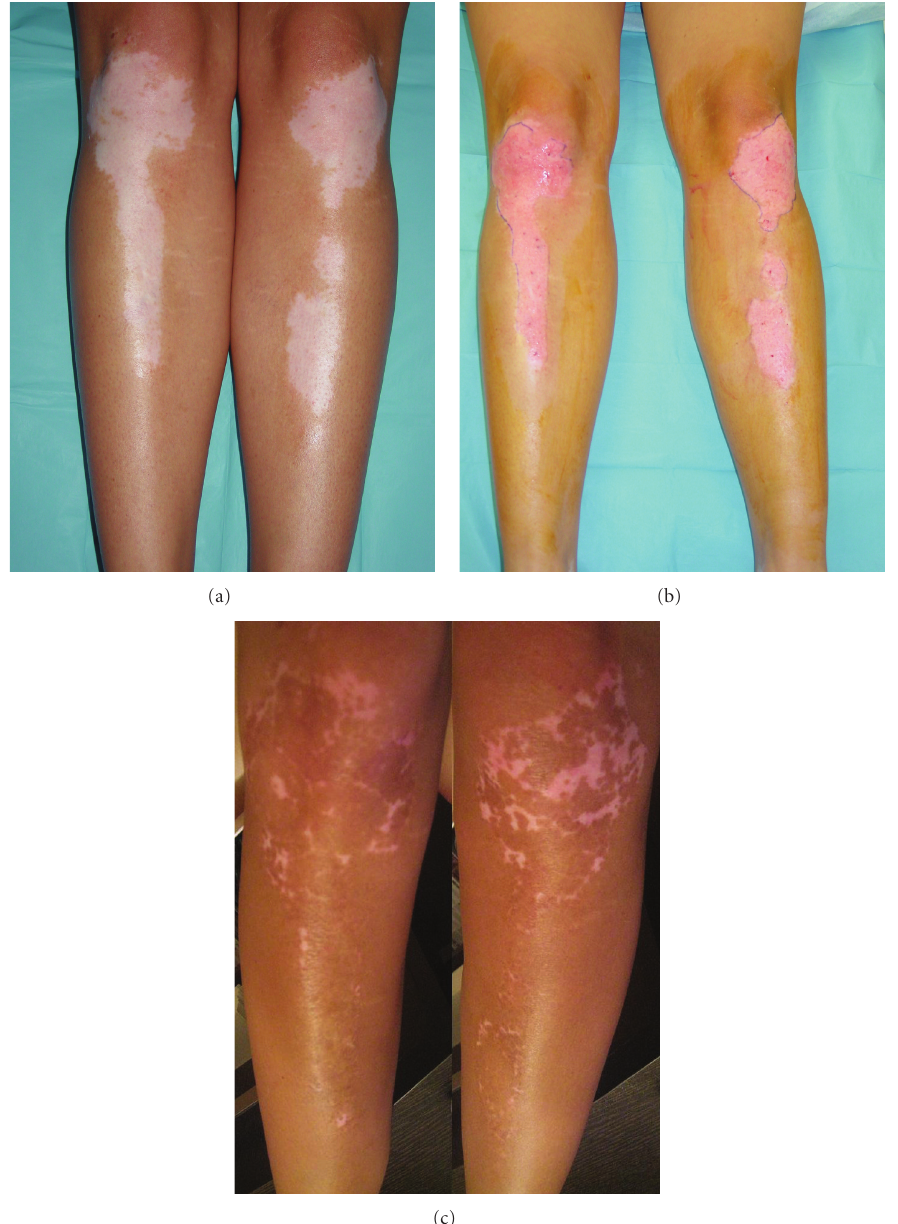
Figure 3: Patient 3. Preoperatively (a), desepidermized lesion after treatment with CO 2 laser (b), and postoperative photographs ( > 90% repigmentation at 16 weeks)